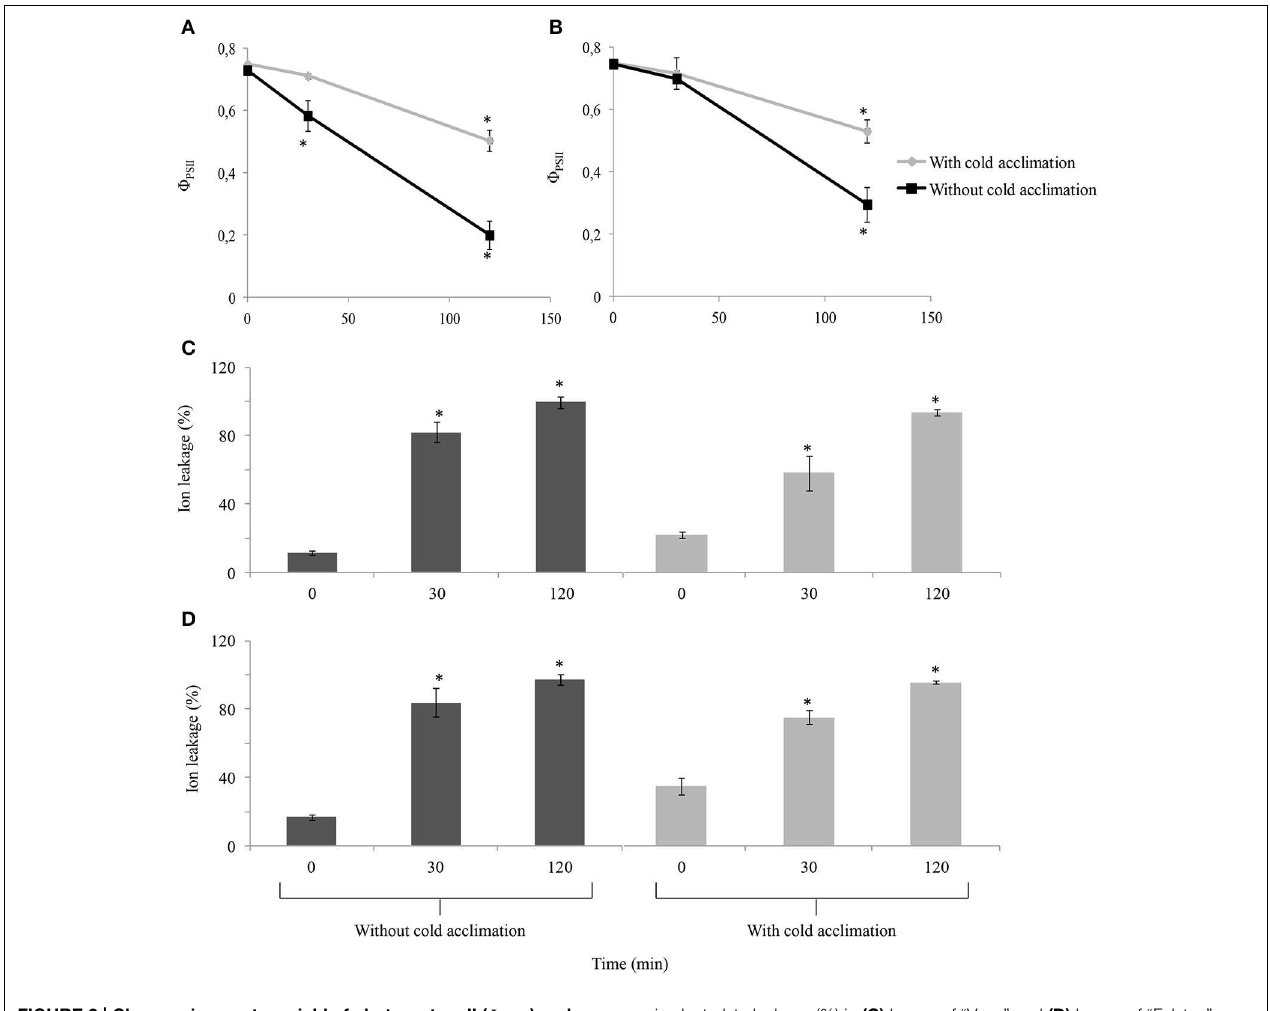
in electrolyte leakage (%) in (C) leaves of “Veyo” and (D) leaves of “Falster.” Data represent the mean ± SE, obtained from three biological replicates of the analysis. The experiments were repeated twice. Asterisks indicate significant differences ( P < 0 . 05 ) from 0 d in (A,B) and from 0min in (C,D)